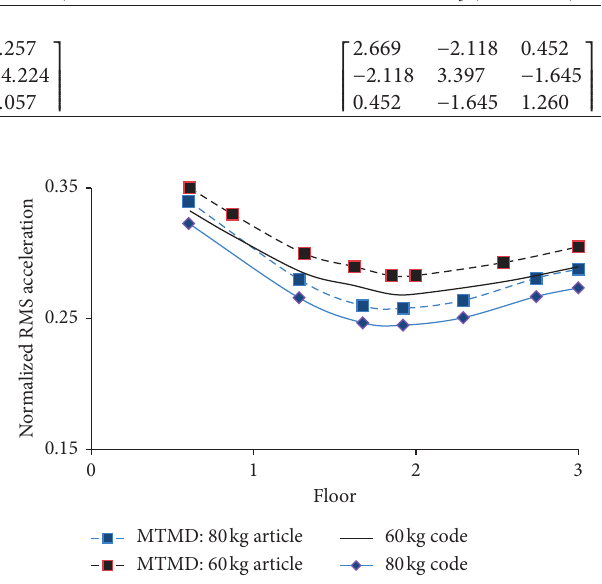
Figure 9: Comparison diagram of controlled structure acceleration results with damper in software analysis with obtained results of the experimental